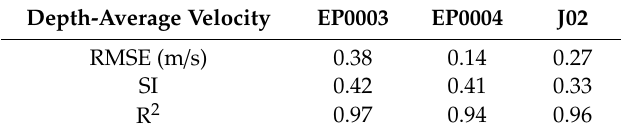
Table 3. Error statistics of the current predictions at stations EP0003, EP0004, and J02.